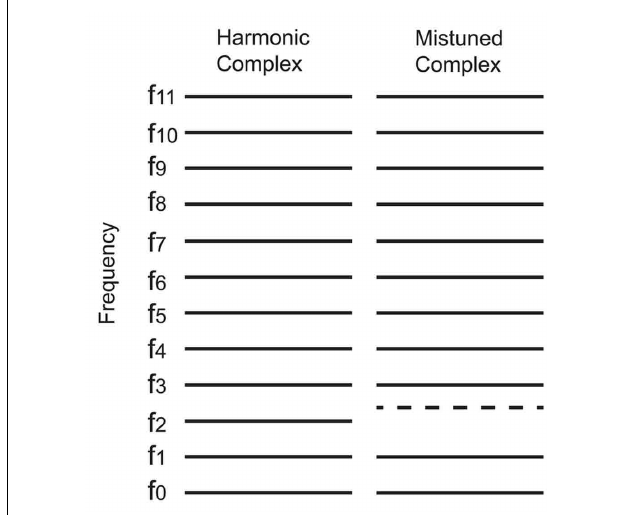
FIGURE 2 | In mistuned harmonic experiments, a complex harmonic sound composed of frequency components that are all multiples of the fundamental frequency ( f 0 ) is heard as a single sound with a buzzy quality (left). When one of the components is mistuned, it stands out as a separate pure-tone object in addition to the remaining complex sound